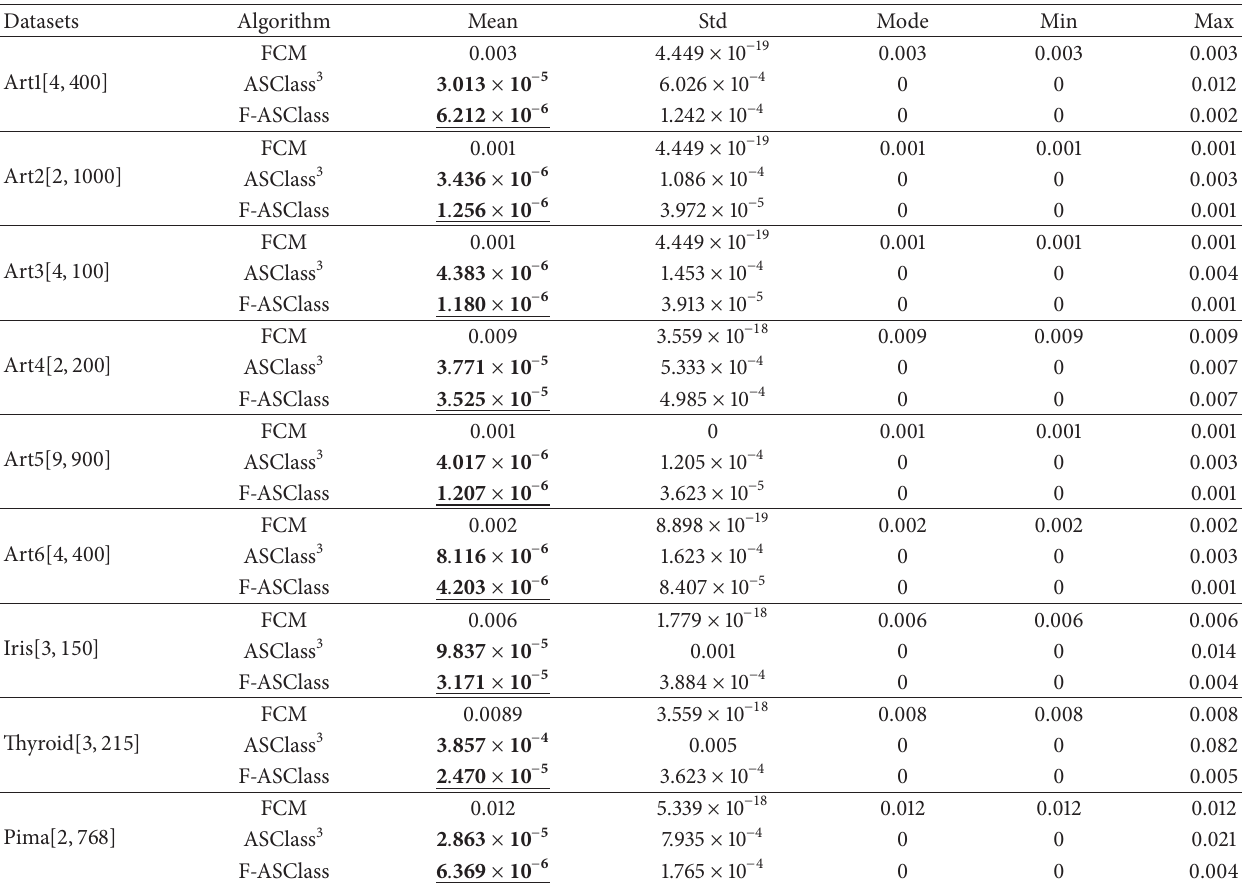
Table 8: Mean, standard deviation, mode, min, and max values of separation index achieved by each clustering algorithm (FCM, ASClass 3 , and F-ASClass) over 20 trials on dataset presented in Table